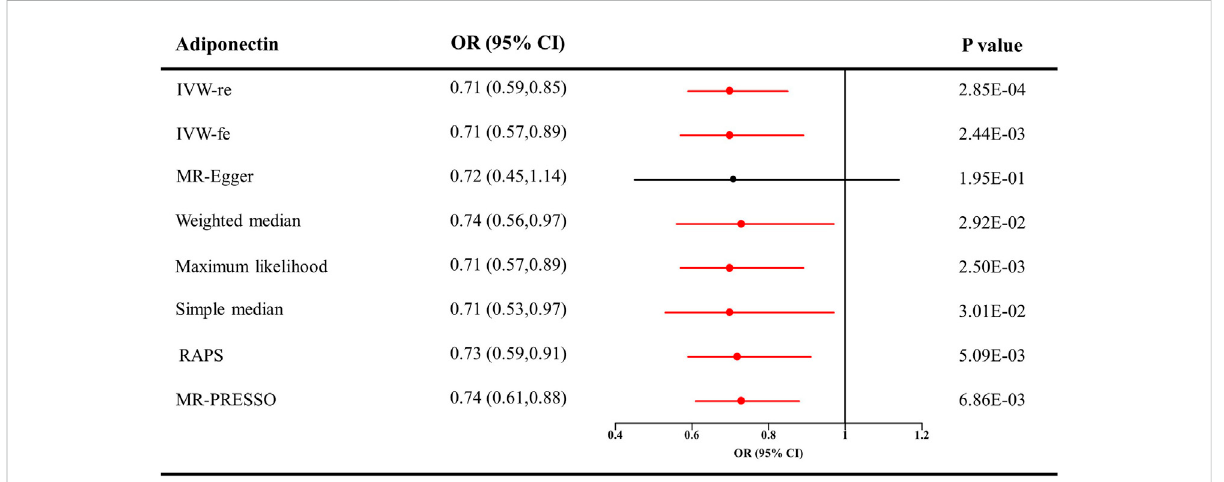
FIGURE 1 Causal estimates of adiponectin on CKD in single-variable MR. Red line, signi fi cant; Black line, not signi fi cant; OR, odds ratio; CI, con fi dence interval; IVW, Inverse variance weighted method; RAPS, robust adjusted pro fi le score; MR, Mendelian randomization; PRESSO, pleiotropy residual sum and outlier; CKD, chronic kidney